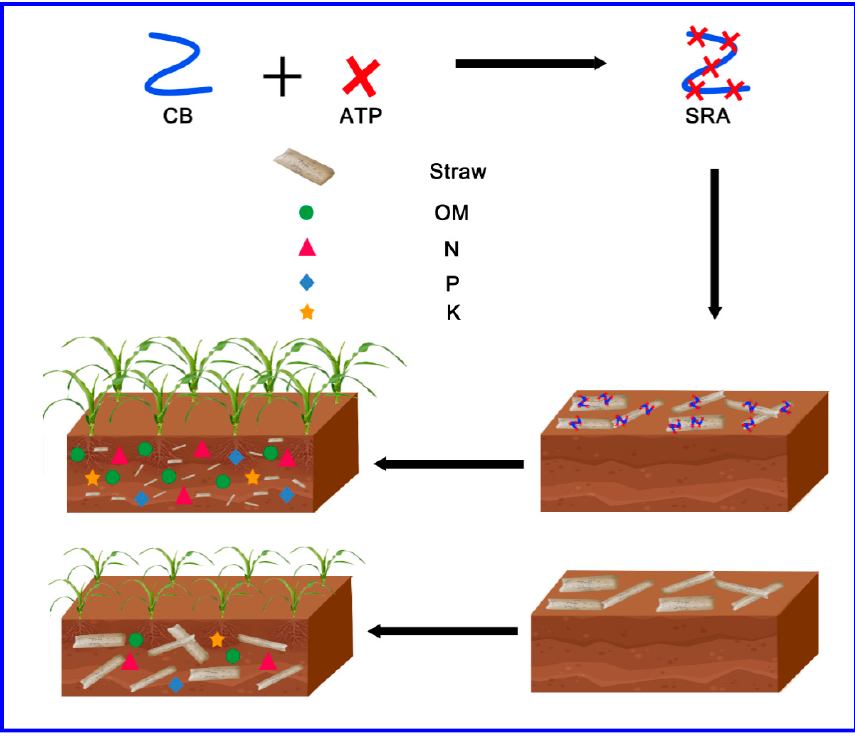
Figure 9. Schematic illustration of fabrication and application of SRA in a field.